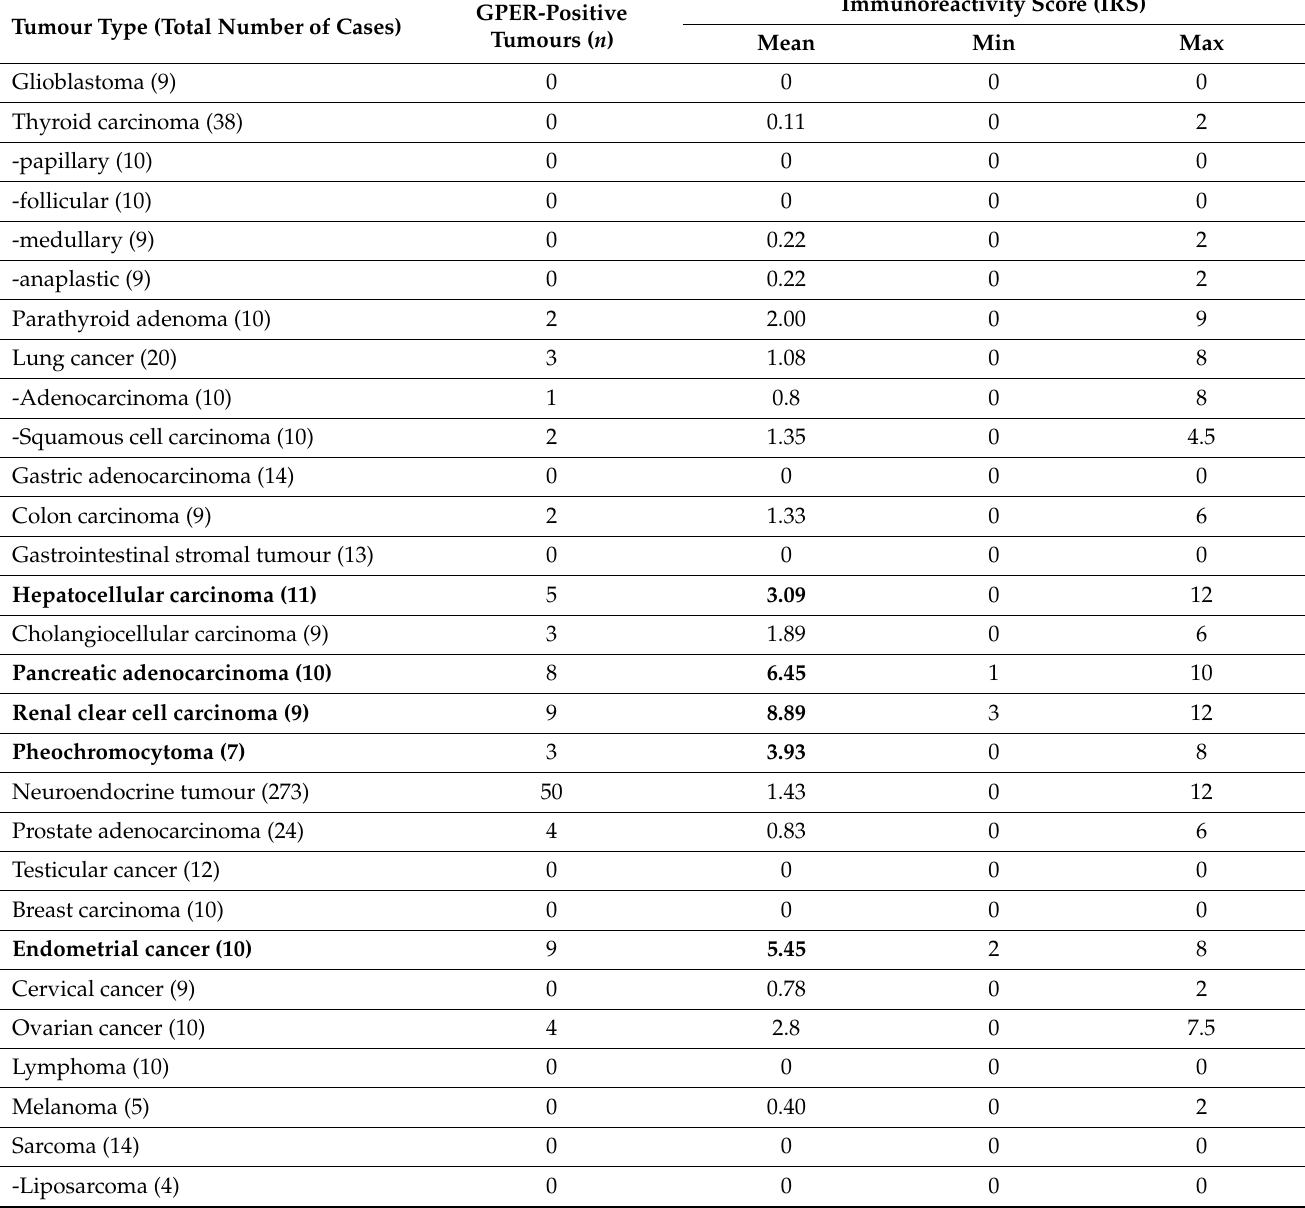
Table 1. Presence of GPER in different tumour entities. Tumours with mean IRS values ≥ 3.0 are marked in